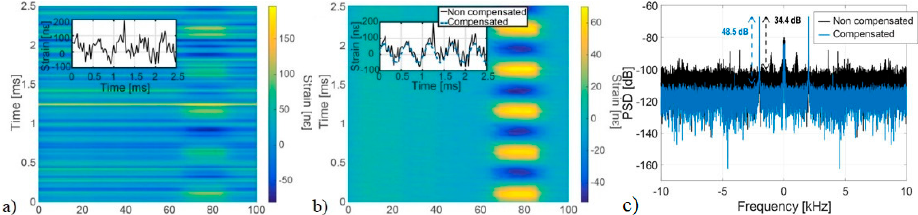
Figure 10. (From [11]) Strain measurements of a sinusoidal vibration applied to 20 m of fibre. The laser has a linewidth of 5 MHz and the induced phase noise was compensated using a 100 m unperturbed fibre. ( a ) Measured strain impaired by laser noise; ( b ) strain after laser noise compensation; ( c ) PSD of the measured strain signal, showing a 14 dB noise floor improvement after laser noise compensation, @2018 IEEE [11].